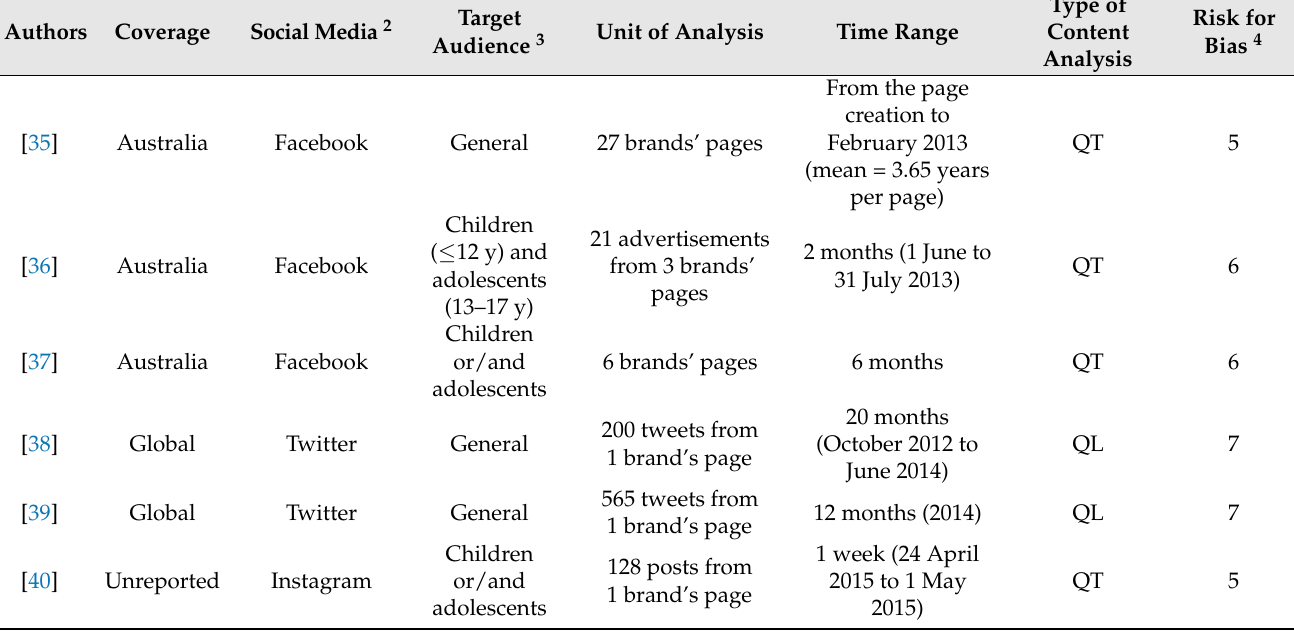
Table 1. Characteristics of the selected